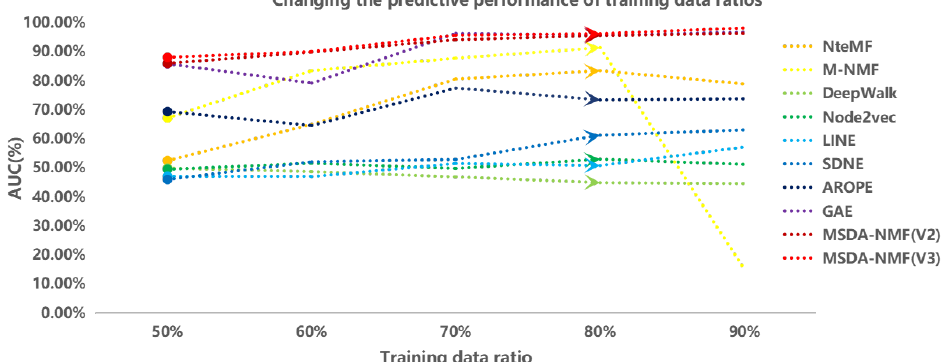
Figure 5. Changing the predictive performance of training data